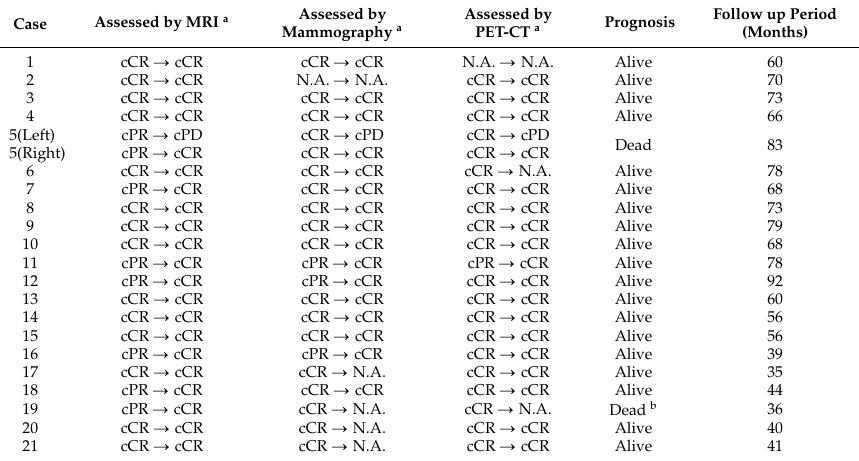
Table 3. Summarized data for all patients. Case